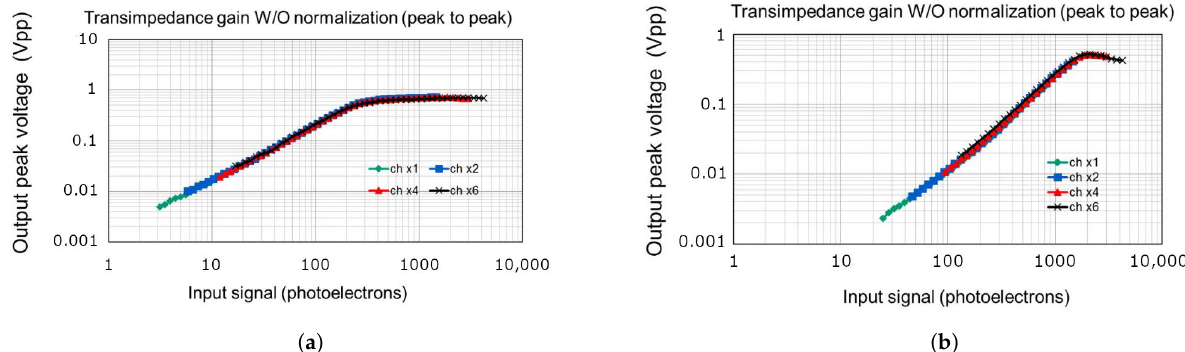
Figure 15. Summation of different amount of channels with PZ cancellation using the Hamamatsu SiPMs S13360 − 6050CS at 6 V of over − voltage. ( a ) High Gain output. ( b ) Low Gain